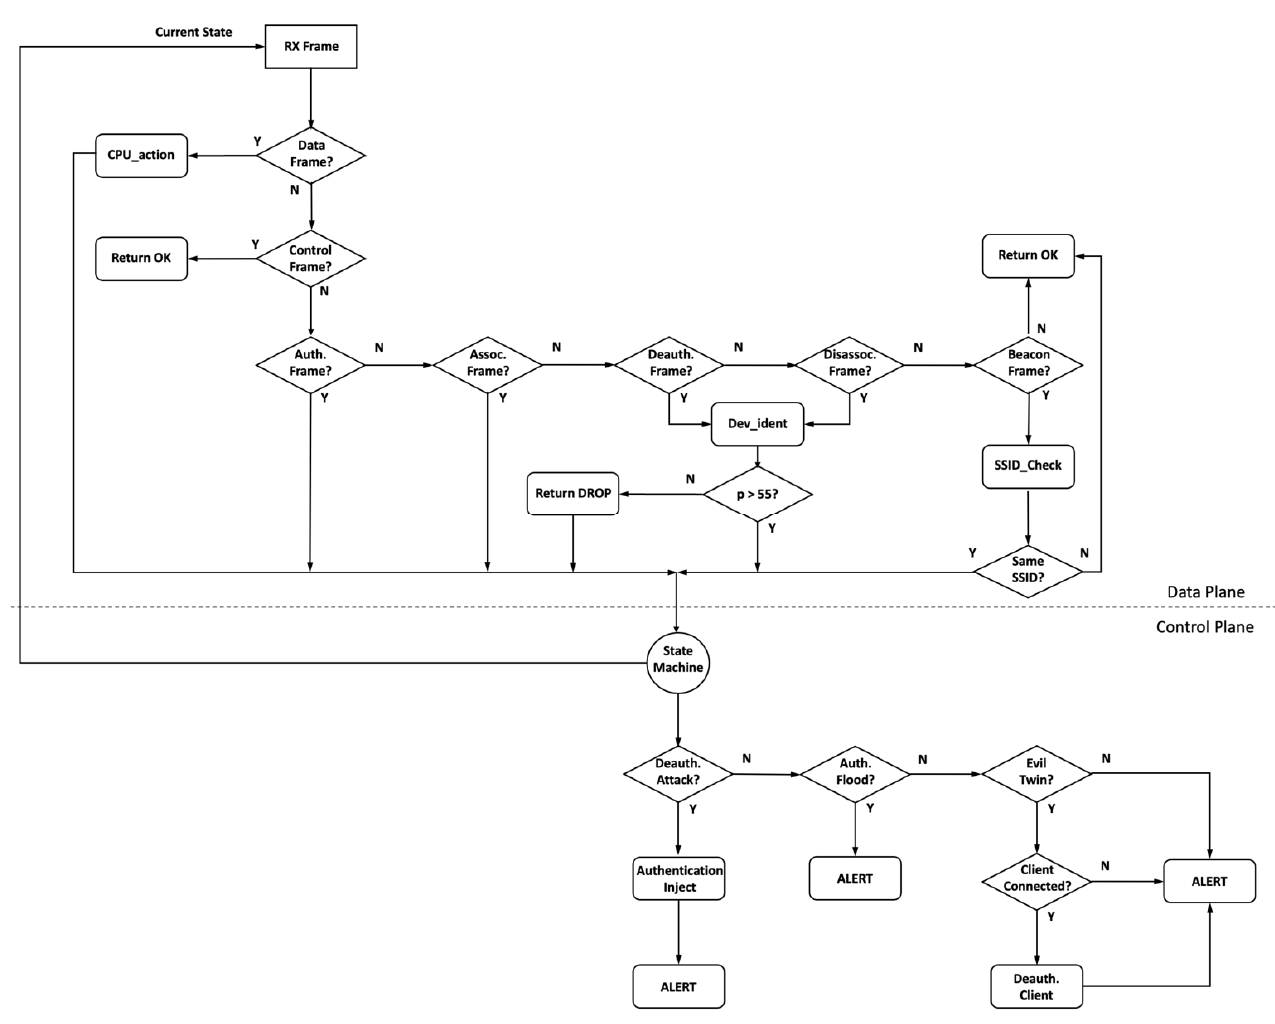
Figure 2. P4 flow diagram.